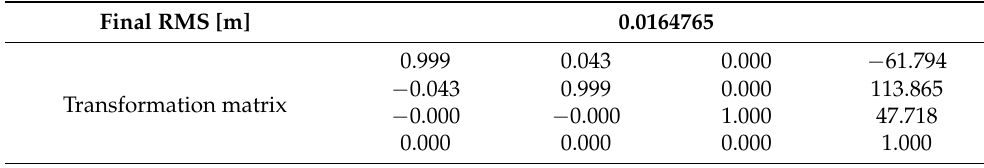
Table 1. TLS point cloud alignment information.